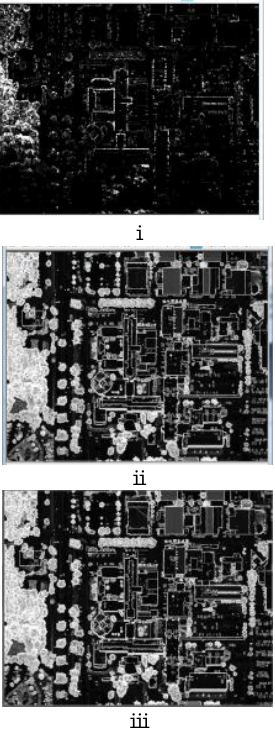
Figure 4: Bands created from range and intensity data